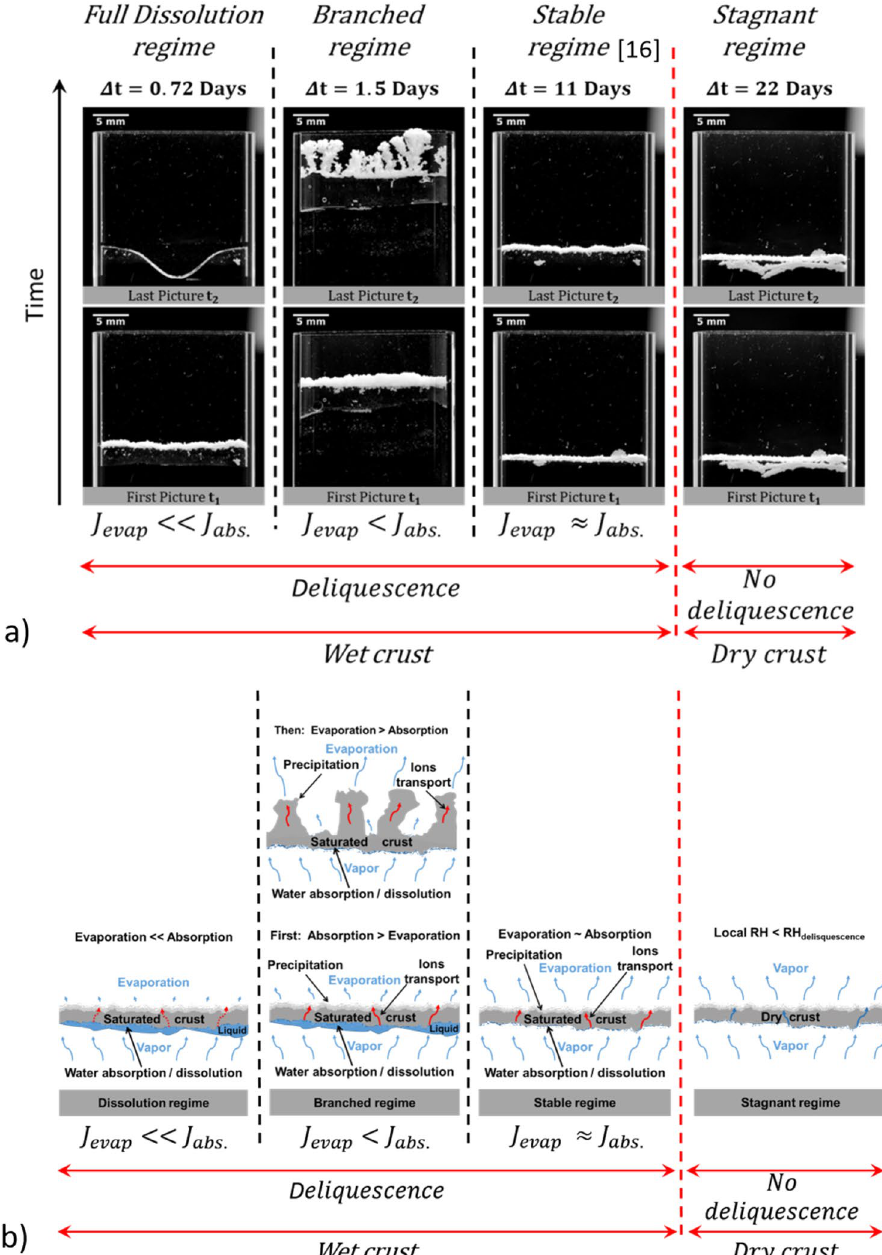
Figure 10. Salt crust dynamics phase diagram. ( a ) Each column of two pictures correspond to a separate experiment, i.e. given initial distances between the crust top surface and the cell top, i.e. h t , and the crust bottom surface and the water level (water table), i.e. h l − h b . For a given column, the picture on the bottom corresponds to the initial image of the crust in the cell whereas the image on the top is the image after the indicated elapsed time (cid:31) t , ( b ) Schematic of the different regimes with indication of main transport and physicochemical mechanisms. “Local RH” means the relative humidity in the vicinity of the